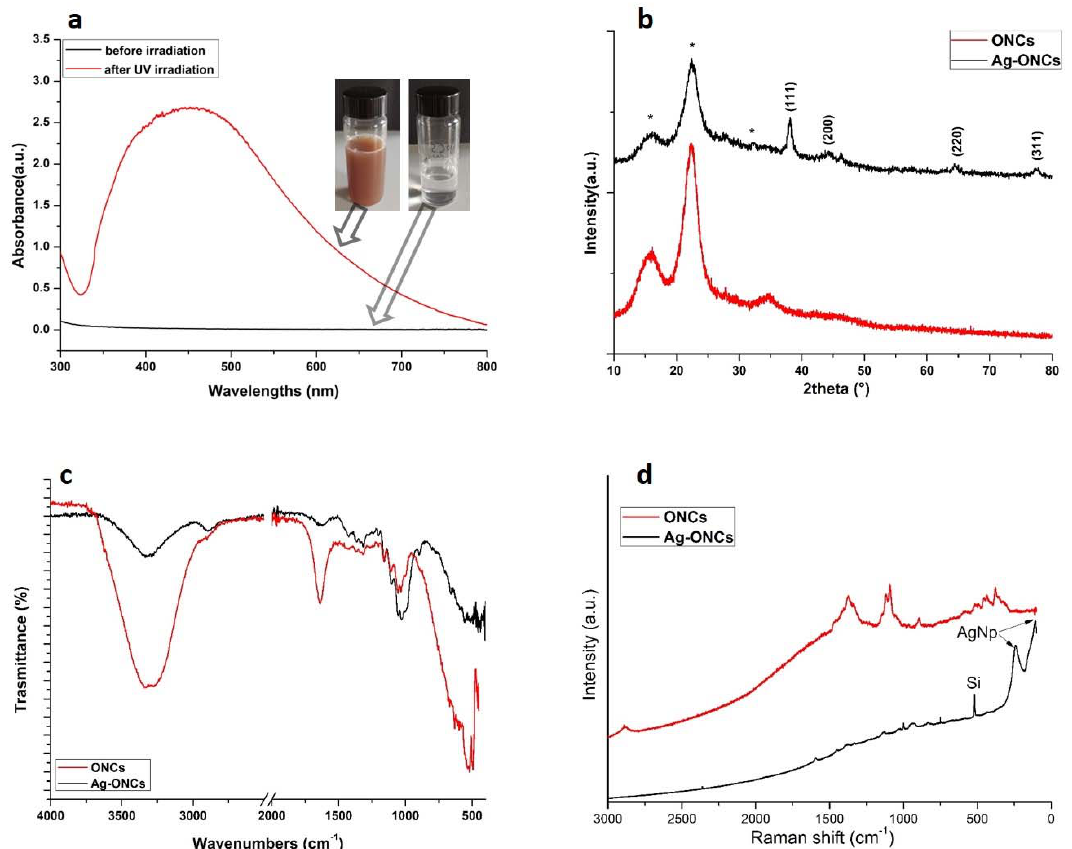
Figure 1. Comparison between for ONCs and Ag–ONCs: ( a ) UV–Vis before and after UV irradiation ( b ) X-ray diffraction (XRD), ( c ) Attenuated Total Reflectance Fourier Transform Infrared (ATR–FTIR), and ( d ) Raman spectra. Note that the * in ( b ) are referred to the XRD cellulose peaks in the nanocomposite.